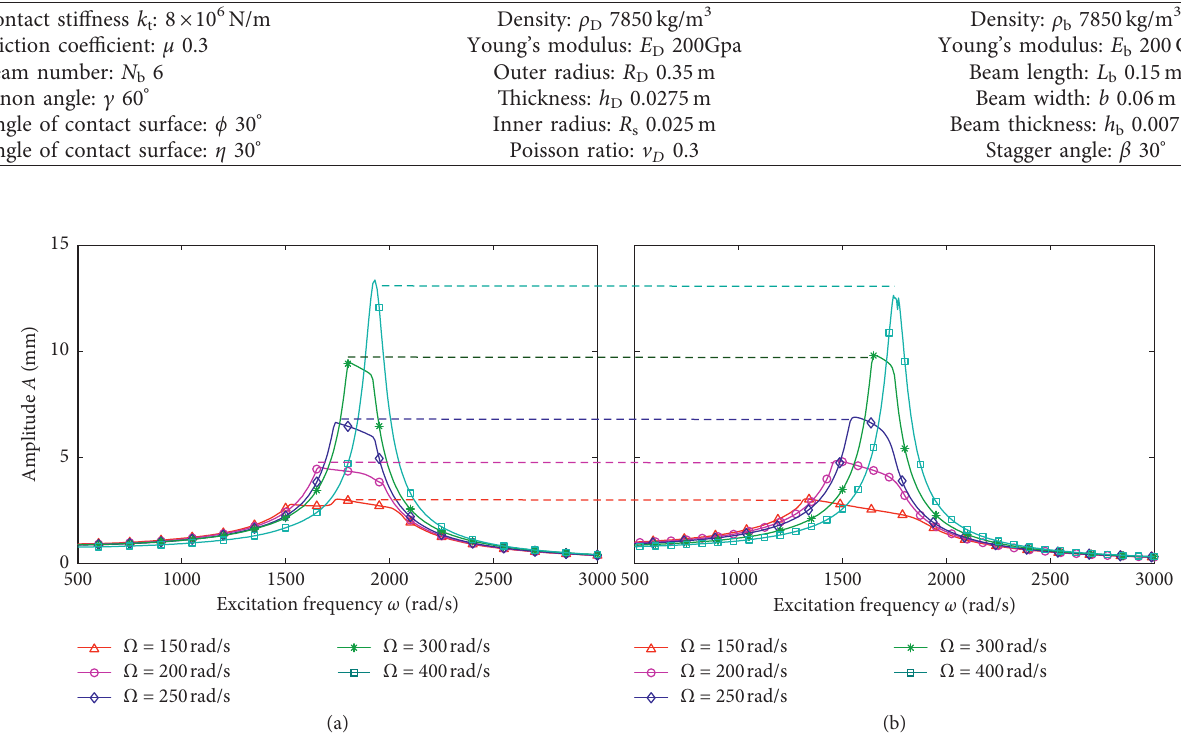
Figure 3: Variation of the beam’s response curves versus rotational speed for F � 300N: (a) the developed model and (b) the FE